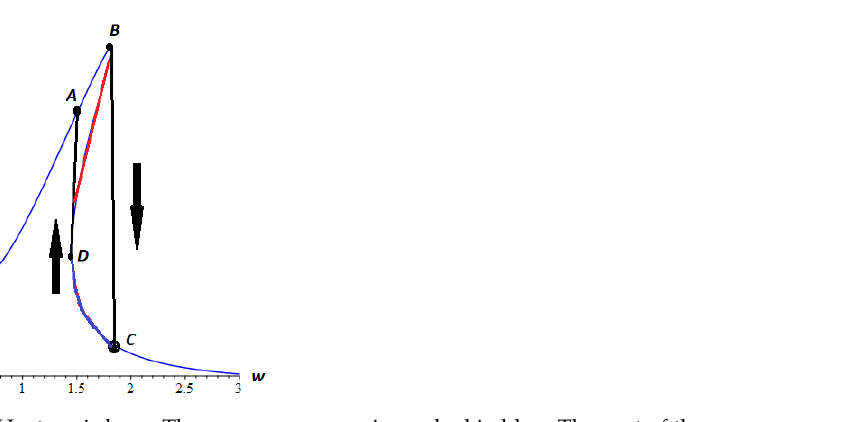
Figure 18. Hysteresis loop. The resonance curve is marked in blue. The part of the resonance curve where the frequency jump occurs is highlighted in